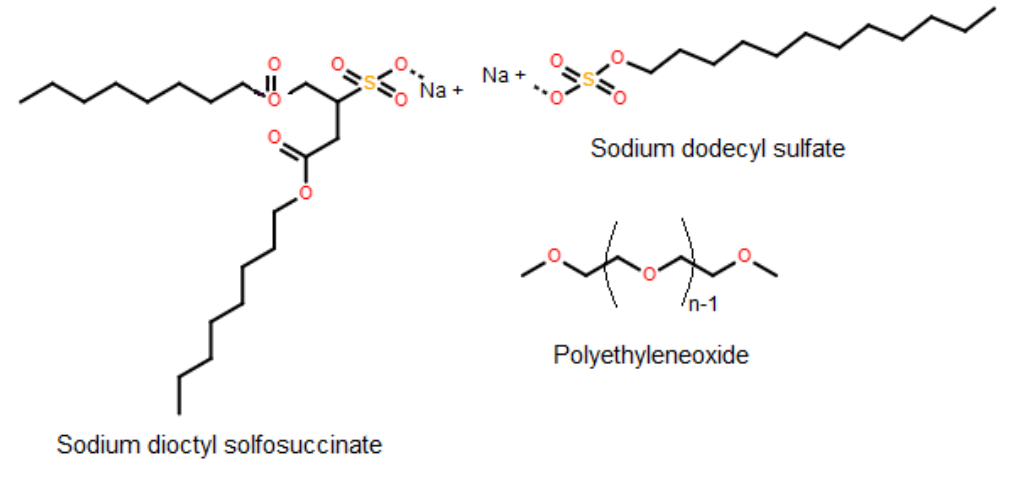
Figure 2. Structure of some common demulsifiers.